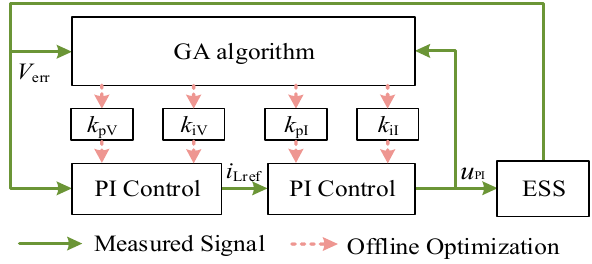
Figure 13. Schematic diagram of the parameter tuning of the conventional PI control.